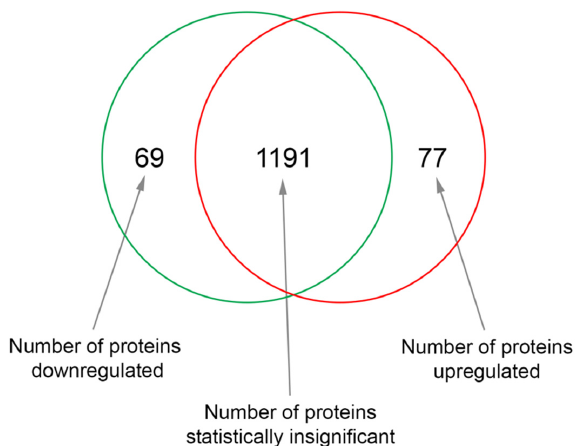
Figure 1. The Venn diagram shows the number of proteins that were significantly upregulated or downregulated in human fetal retinal pigment epithelial cells (RPE) cultured in Dulbecco’s Modified Eagle’s Medium (DMEM) with 1% sericin compared to cells cultured in DMEM without sericin.